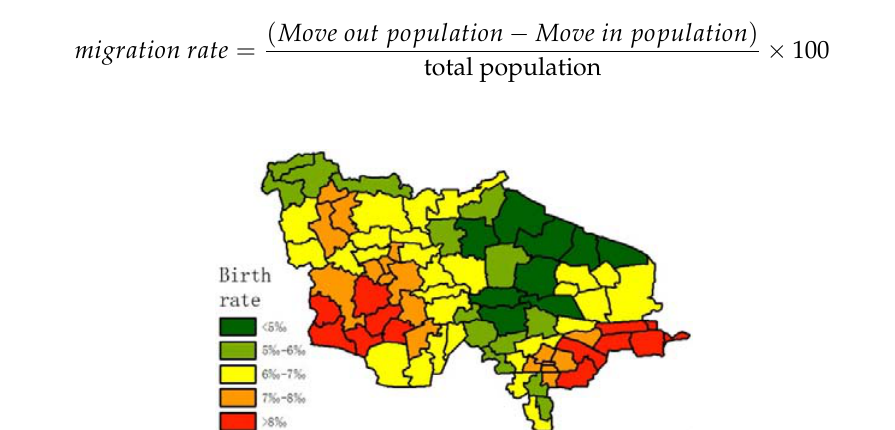
Figure 10. Average birth rate of each town from 2011 to 2015.